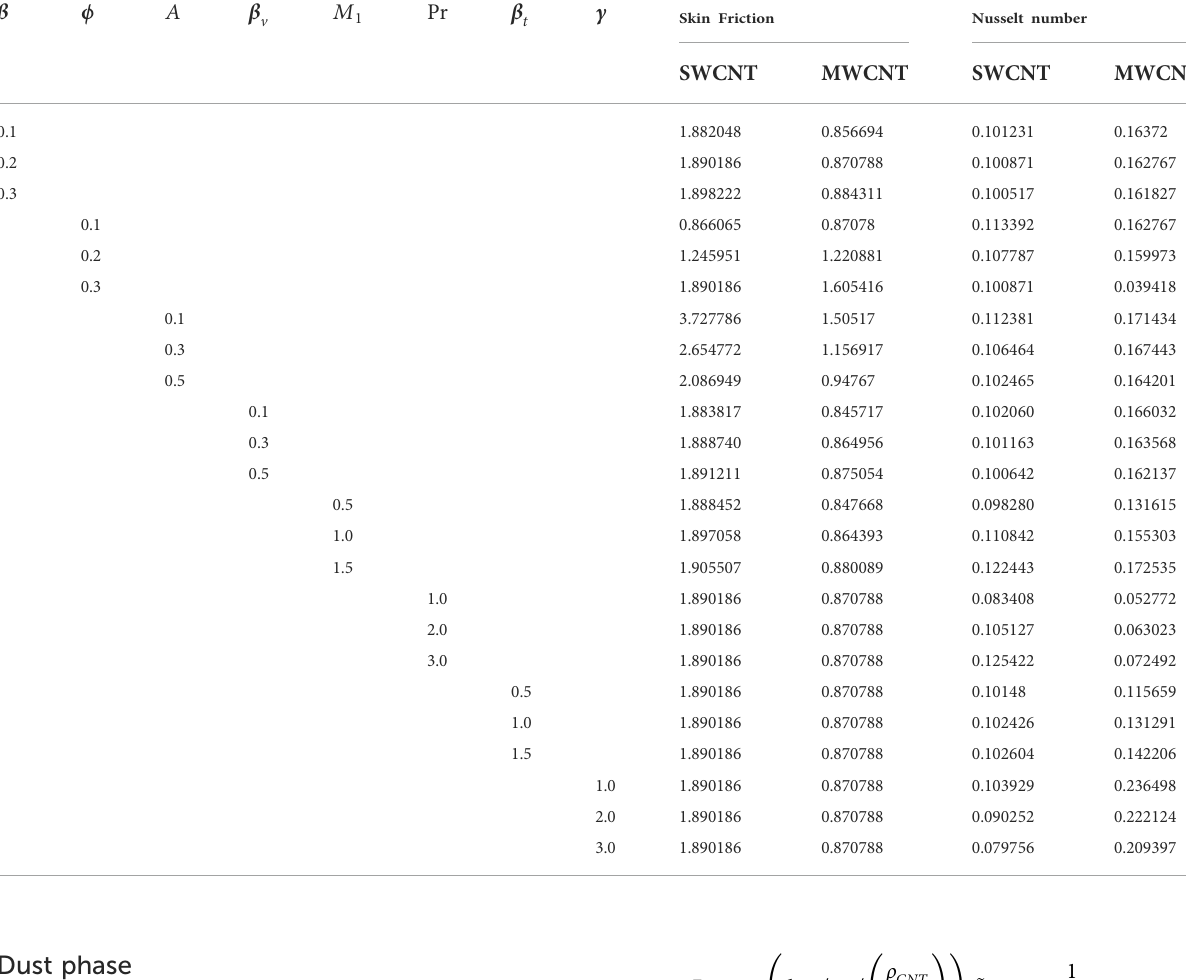
TABLE 3 Numerical values of Re 1/2 x C f and Re 1/2 x Nu x for various